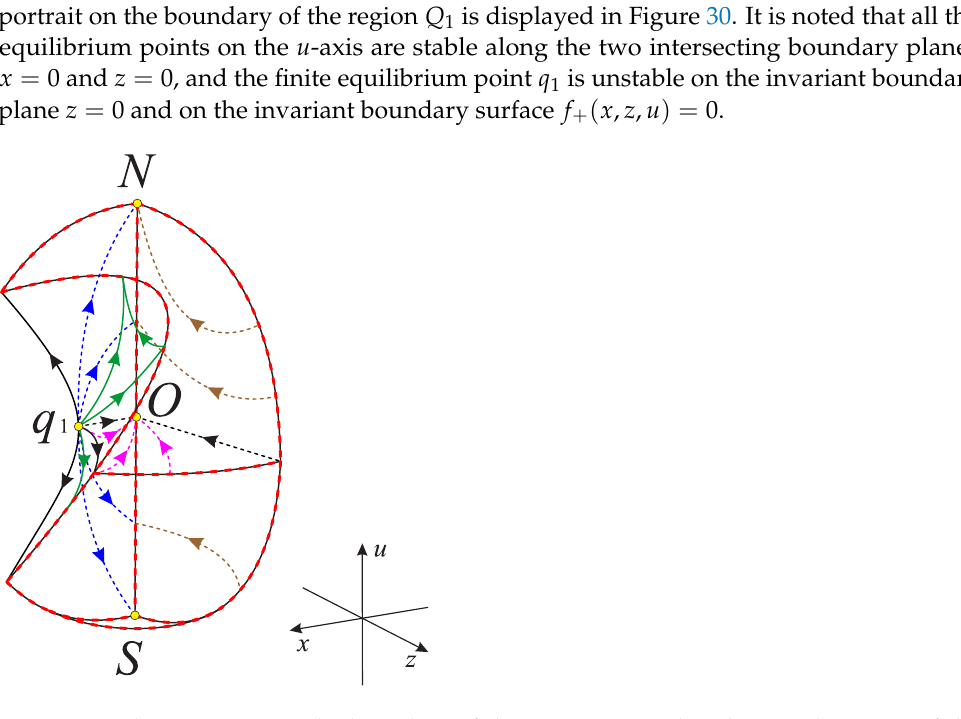
Figure 30. Phase portrait on the boundary of the region Q 1 , and O denotes the center of the Poincaré